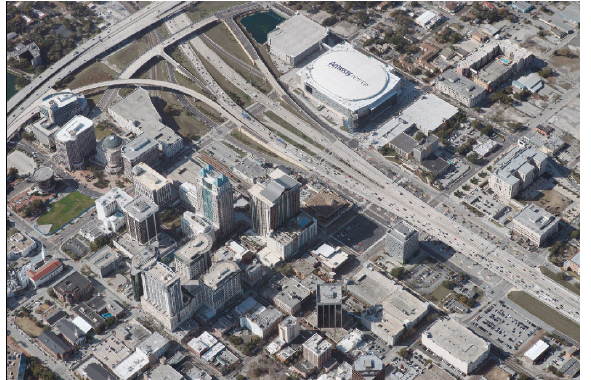
Figure 2a. An airborne oblique image